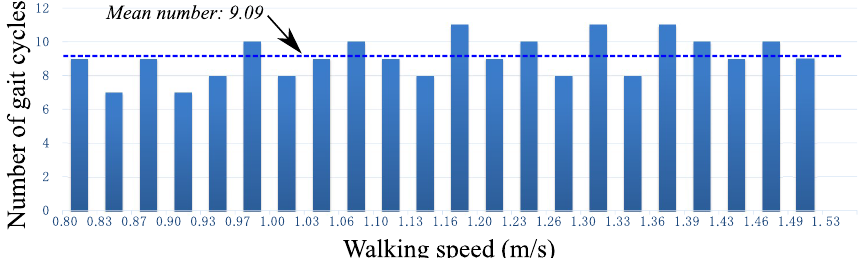
Figure 4. The statistical result of gait cycles from the gait set ordered by walking